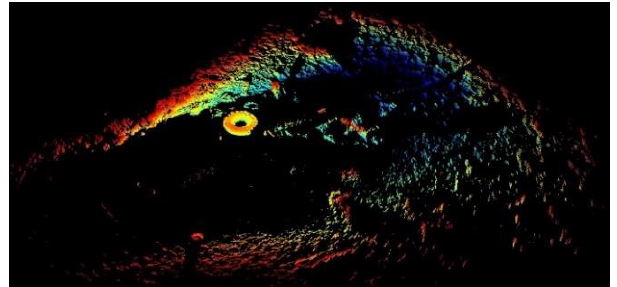
Figure 7. 3D results after removing the seabed.